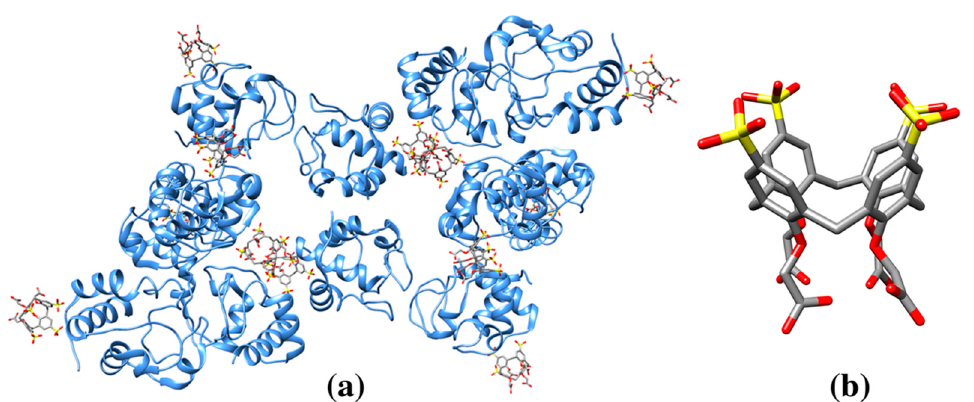
Figure 6. ( a ) Ribbon drawing representation and crystal packing of yeast cytochrome c in complex with octa-anionic calix [4] arene ( sclx4mc , pdb entry 6haj). The negative charges of calixarene molecule are involved in electrostatic interactions with the positive charges of specific arginine and lysine residues from protein molecules crystallographically related. ( b ) Octa-anionic calix[4]arene molecule (cif code LVT).